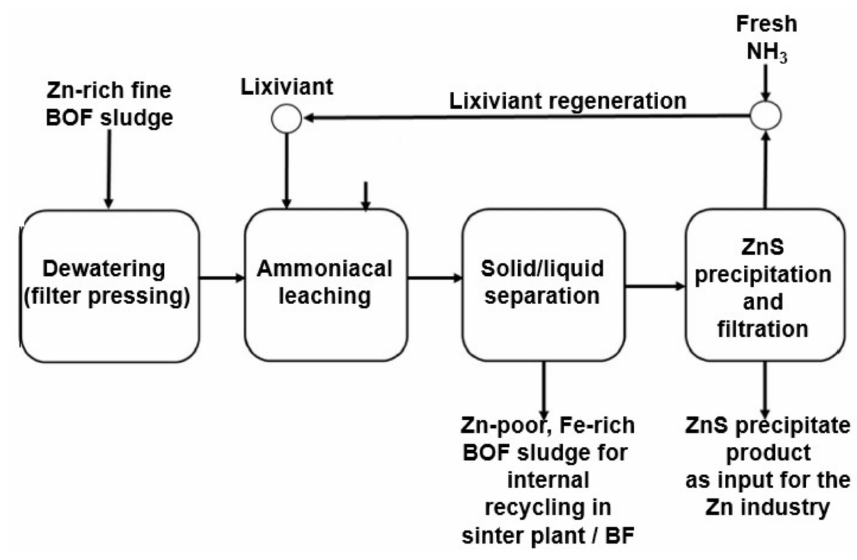
Figure 8. Schematic flow chart of the SAMEX process